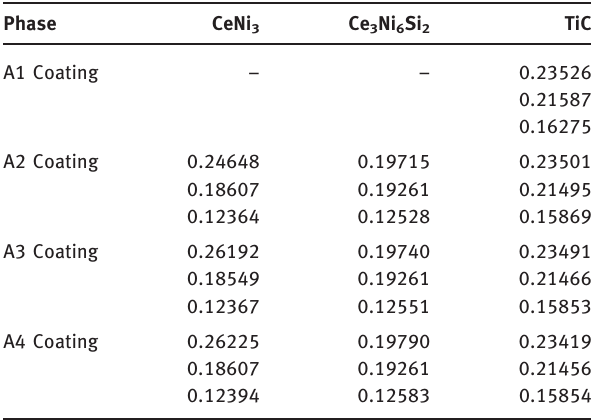
Table 5: d of peaks in the four kinds of